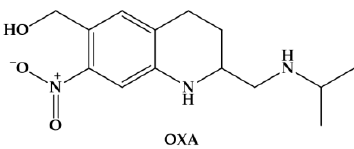
Figure 2. Chemical structure of oxamniquine (OXA), an antischistosomal drug used against Schistosomiasis mansoni .